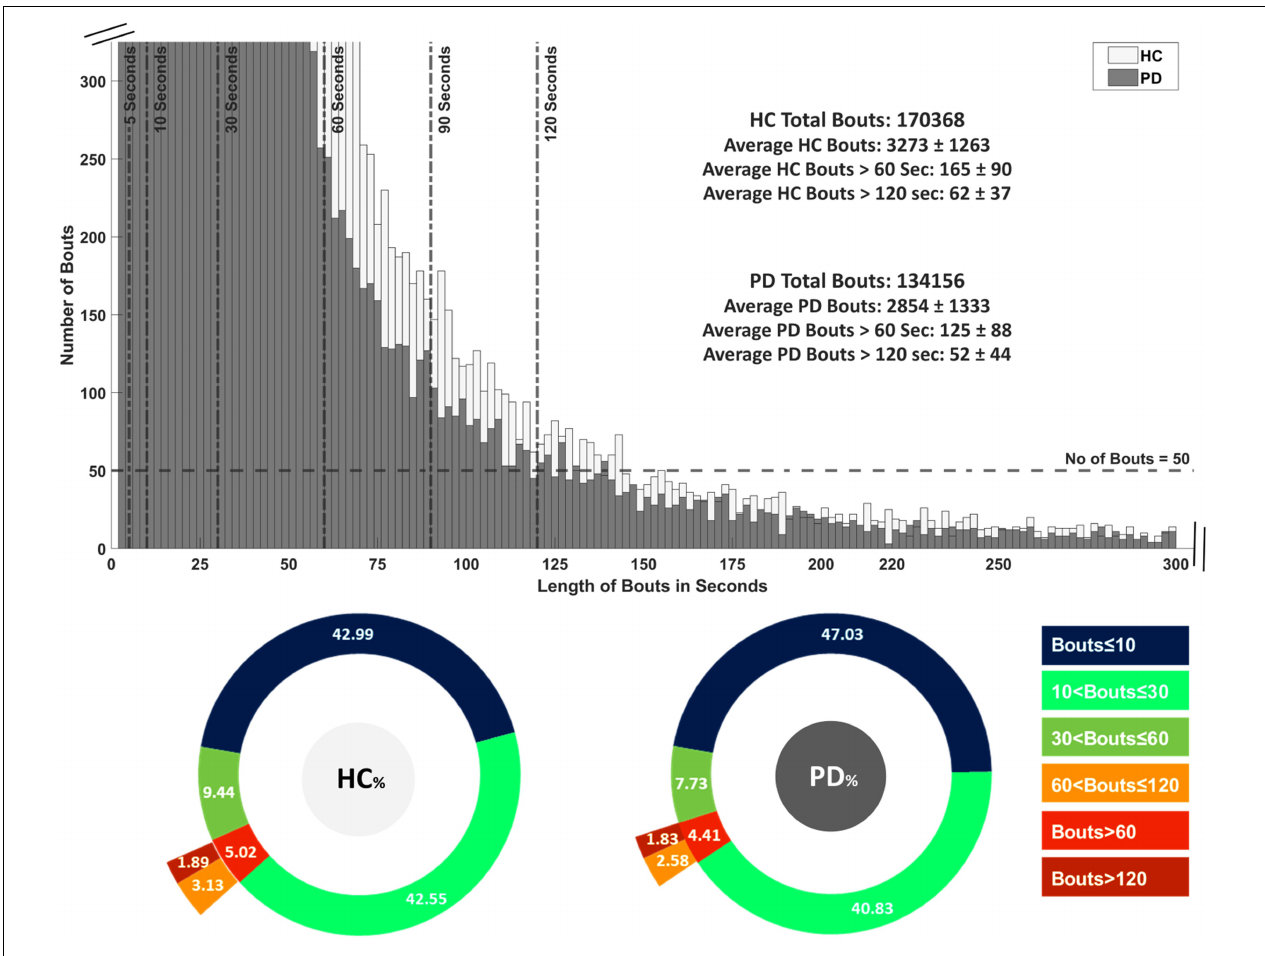
FIGURE 2 | Distribution of all detected walking bouts (WBs) in Parkinson’s disease (PD) and healthy control (HC) groups in the real-world assessment of 7 days. WB are categorized intro 14 thresholds based on time in seconds followed by their average of 7